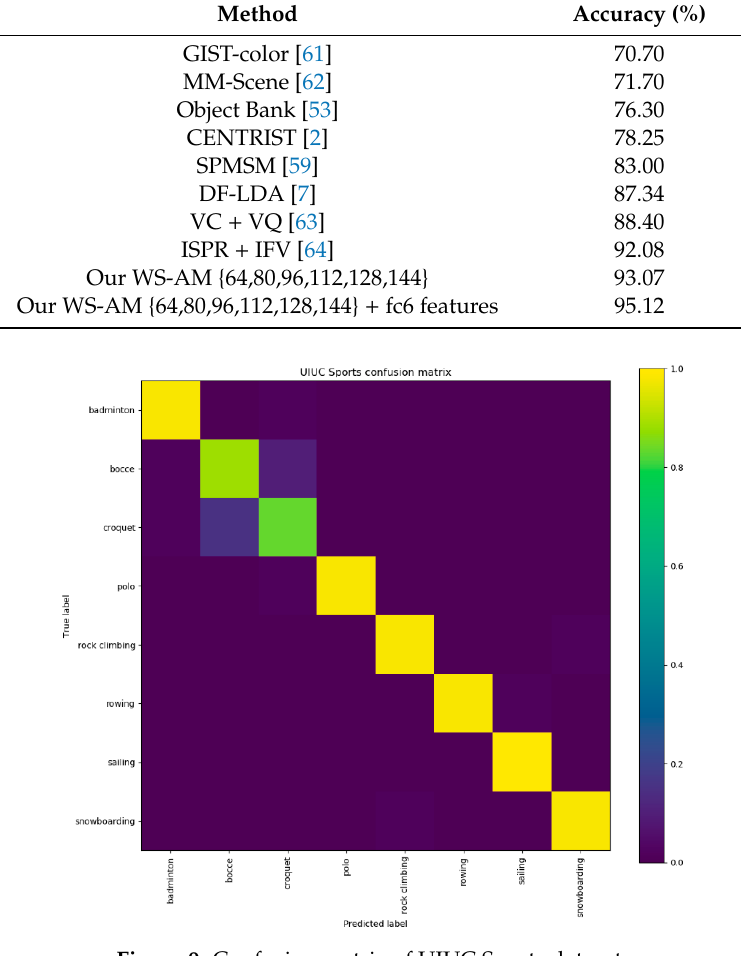
Table 4. Accuracy comparison on UIUC Sports dataset.